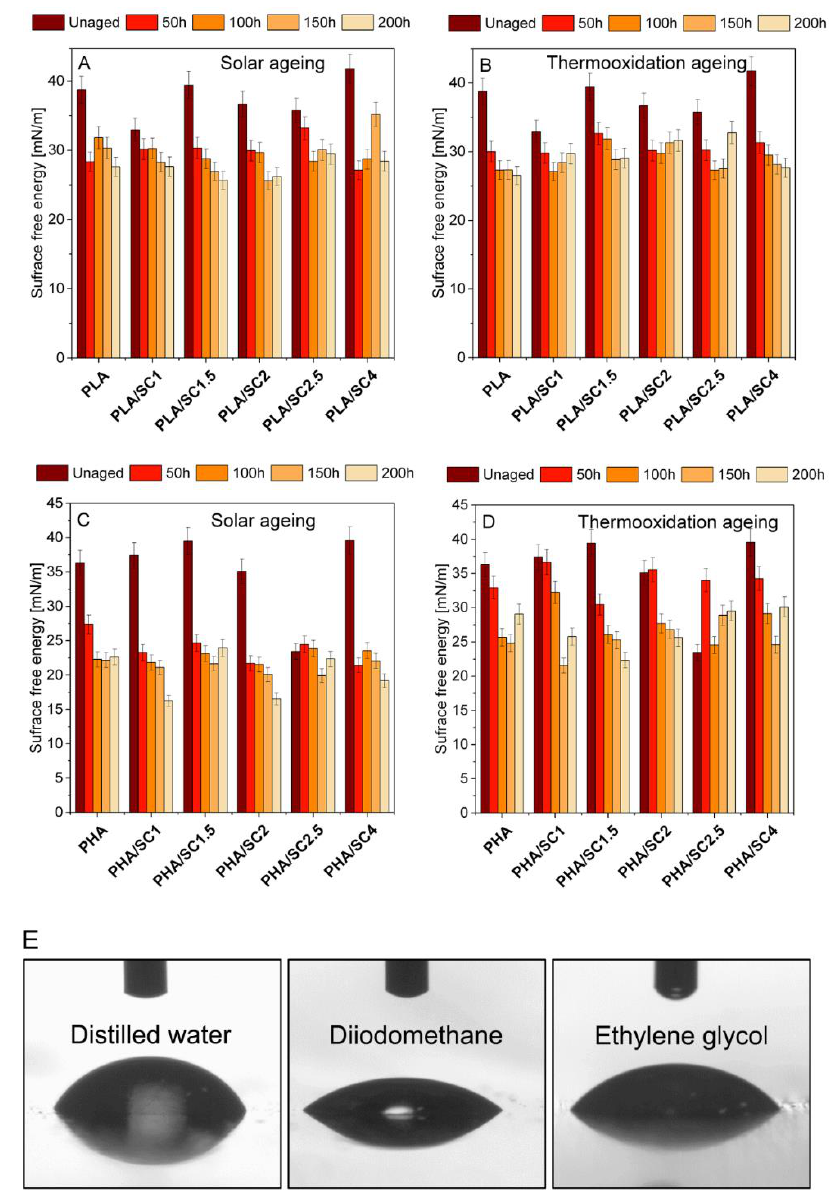
Figure 3. The changes in PLA ( A , B ) and PHA ( C , D ) with succinic acid (SC) surface free energy after solar and thermooxidation aging; drop of distilled water, diiodomethane and ethylene glycol on PLA before aging ( E